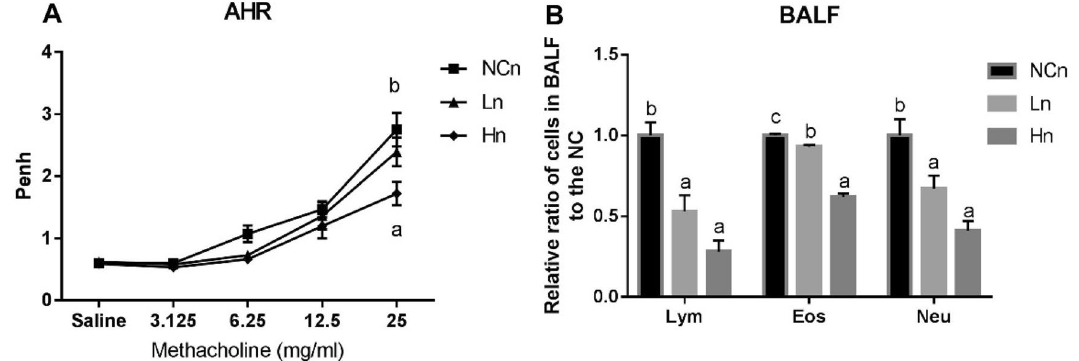
Figure 7. Airway hyperresponsiveness (AHR) ( A ) and immune cells in bronchoalveolar lavage fluid (BALF) ( B ) of OVA-injected (s.c.) mice with additional intranasal administration. NCn mice gavaged with saline, negative control, Ln mice gavaged with low-dose LcSFB, Hn mice gavaged with high-dose LcSFB. Different superscript letters (a, b, c) indicate significant differences at p < 0.05; one-way ANOVA with Tukey HSD post- hoc tests ( n =